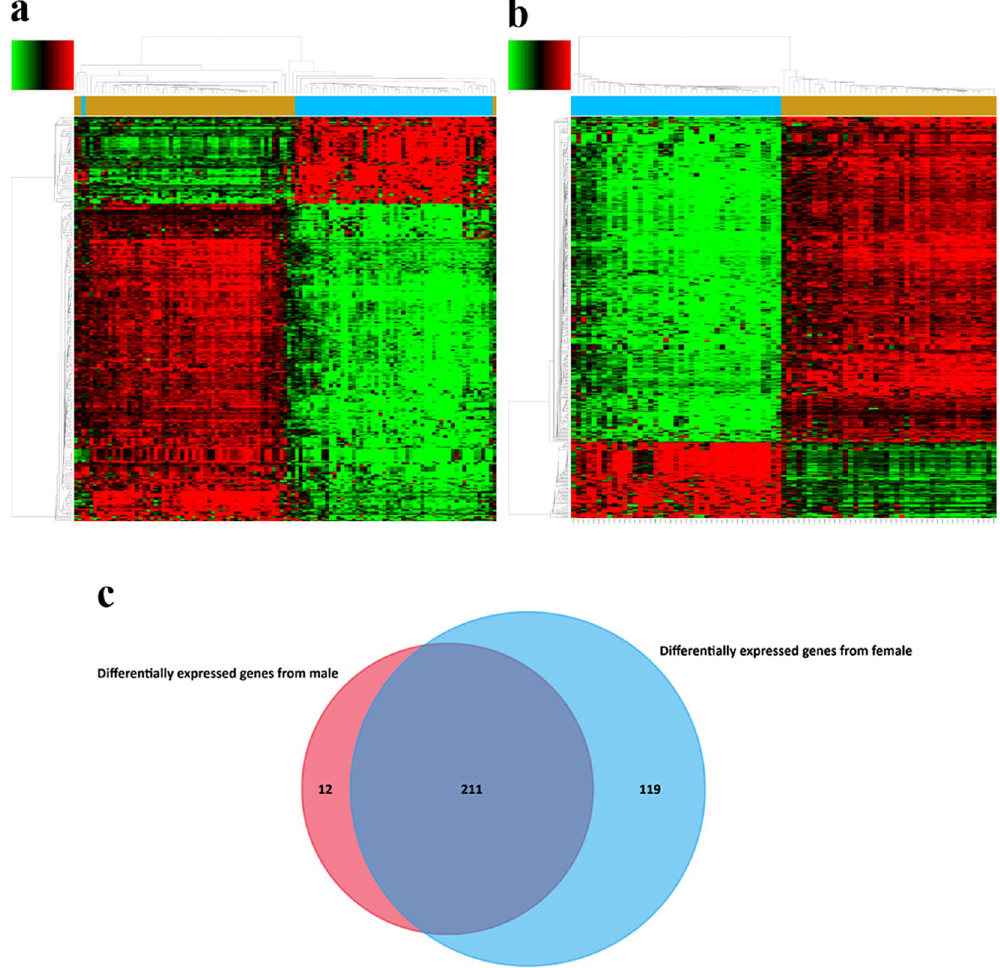
Figure 2. DEGs between lung adenocarcinoma and normal lung tissues for GSE40791. ( a ) Heat map for potential DEGs (n = 321) from males (lung adenocarcinoma n = 53, in blue; normal lung tissues n = 58, in yellow). ( b ) Heat map for potential DEGs (n = 463) from females (lung adenocarcinoma n = 41, in blue; normal lung tissues n = 42, in yellow). ( c ) Duplicate expressions with the same gene symbol and those without a specific gene symbol were removed; the Venn diagram shows DEGs (n = 223) from males, DEGs (n = 330) from females and the co-expressed genes (n = 211) that eliminated gender